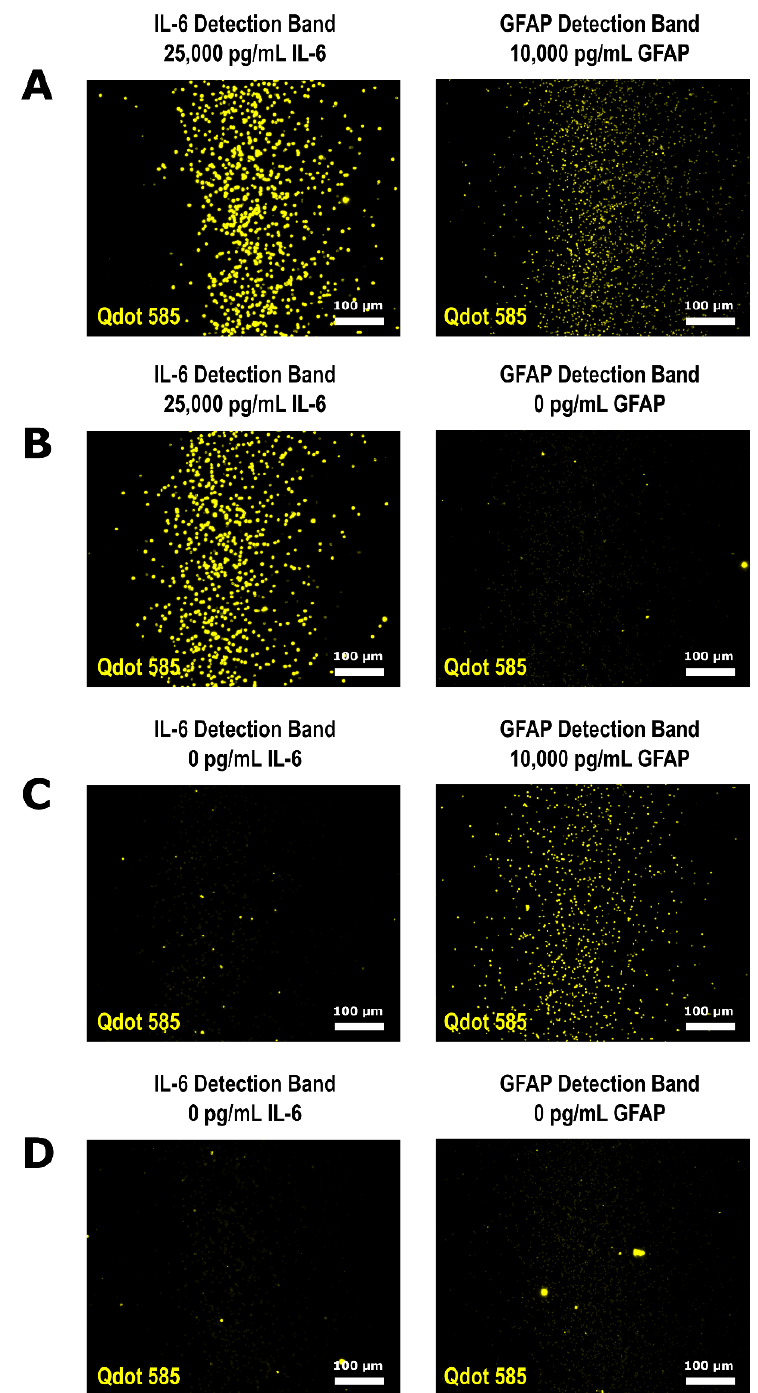
Figure 5. Multiplex of the IL-6 QLISA and the GFAP QLISA where the fluorescent signal for both assays is from Qdot TM 585. Both assays were run in the same microcentrifuge tube on the same spiked buffer sample. The representative fluorescence images from the variable height device detection bands of ( A ) a sample containing 25,000 pg/mL IL-6 and 10,000 pg/mL GFAP, ( B ) a sample containing 25,000 pg/mL IL-6 and 0 pg/mL GFAP, ( C ) a sample containing 0 pg/mL IL-6 and 10,000 pg/mL GFAP, and ( D ) a sample containing 0 pg/mL IL-6 and 0 pg/mL GFAP all have the same brightness/contrast for ease of visual comparison. Table 1. Variable height channel parameters and assay beads used to generate the data in Figures 2 – 5. All channels had the same general height profile shown in Figure 1D between the inlet and outlet heights listed. Figure Inlet Height (µm)